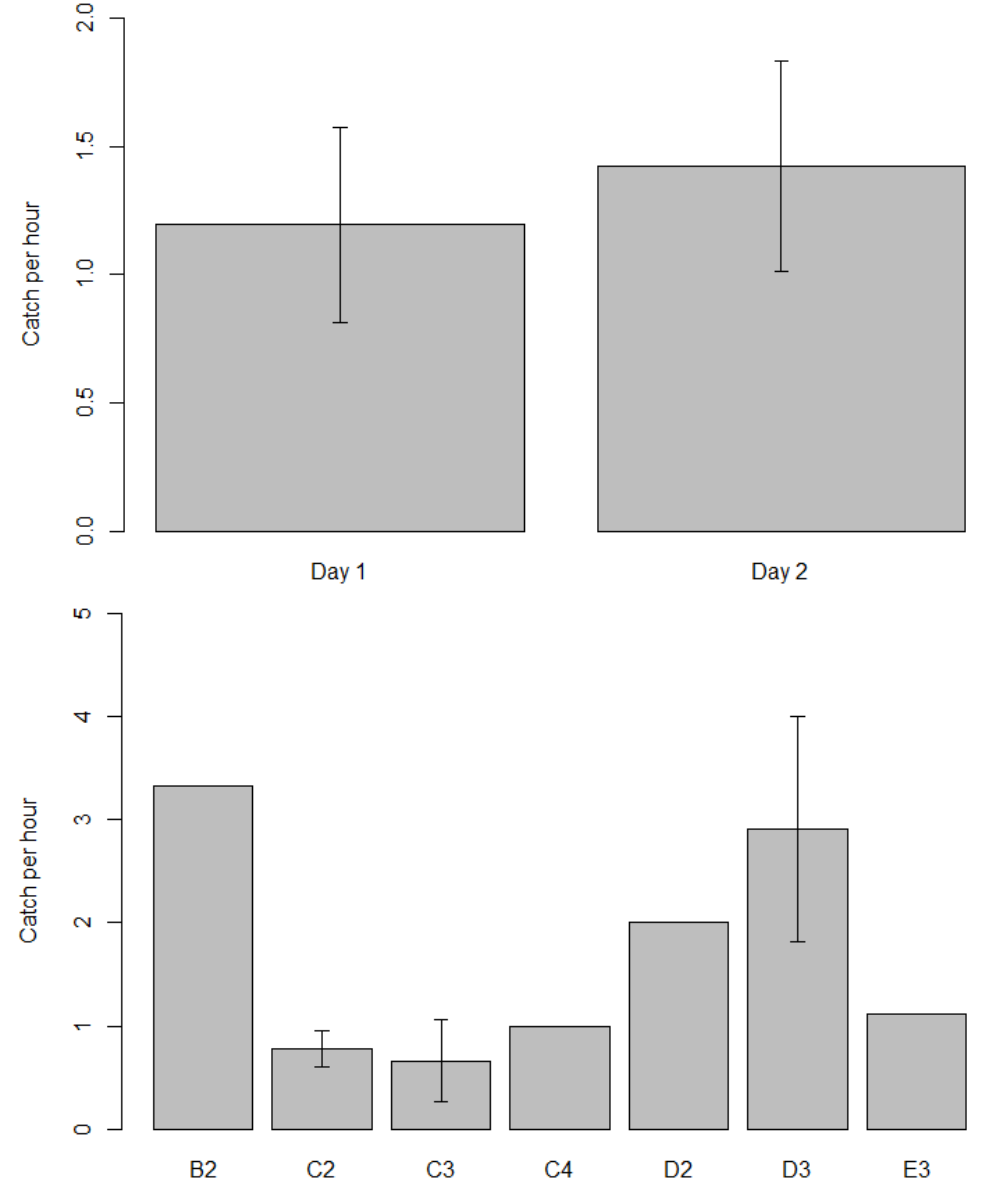
Figure 3. Differences in catch per unit effort (CPUE) ± SE of fish by day ( top ) and by location ( bottom ). See Figure 1 for grid cell locations.